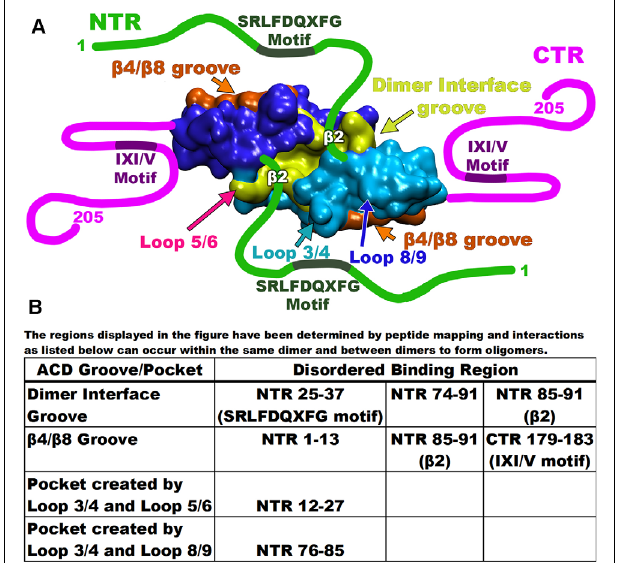
FIGURE 4 | Map of Hsp27 interacting regions. (A) Each of the monomers is depicted as either blue or cyan with the dimer interface groove in yellow and the β 4/ β 8 groove for each monomer in orange. Disordered regions are drawn as either green or magenta lines with the binding motifs as labeled. Important interaction loops are indicated by arrows. (B) The table at the bottom lists each of the disordered binding regions and the groove/pocket that bind as described by peptide